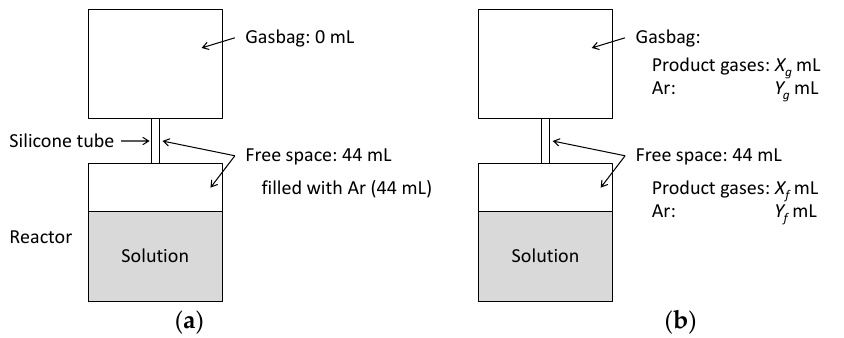
Figure A3. Schematic diagram of the reactor and gasbag ( a ) before and ( b ) after solution-plasma treatment.